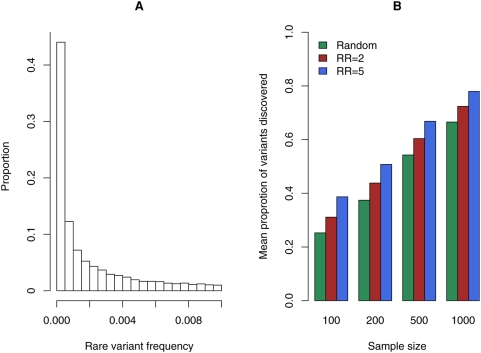
Distribution of the frequencies of rare variants and the average proportion of rare variants discovered in randomly ascertained and case samples.Data were generated using coalescent simulation under the neutral Wright–Fisher model with a scaled mutation rate θ = 4. Panel (A) displays the distribution of rare variants with frequency ≤0.01 for 100 haplotype pools each with 10,000 haplotypes. Panel (B) displays the mean proportion of variants discovered for randomly ascertained samples and for case samples of N = 100, 200, 500, and 1,000 individuals. Results are based upon 10,000 replicates. Case samples were generated with 50% of rare variants randomly chosen to be causal each with a genotypic RR of 2 or 5 under the additive model.